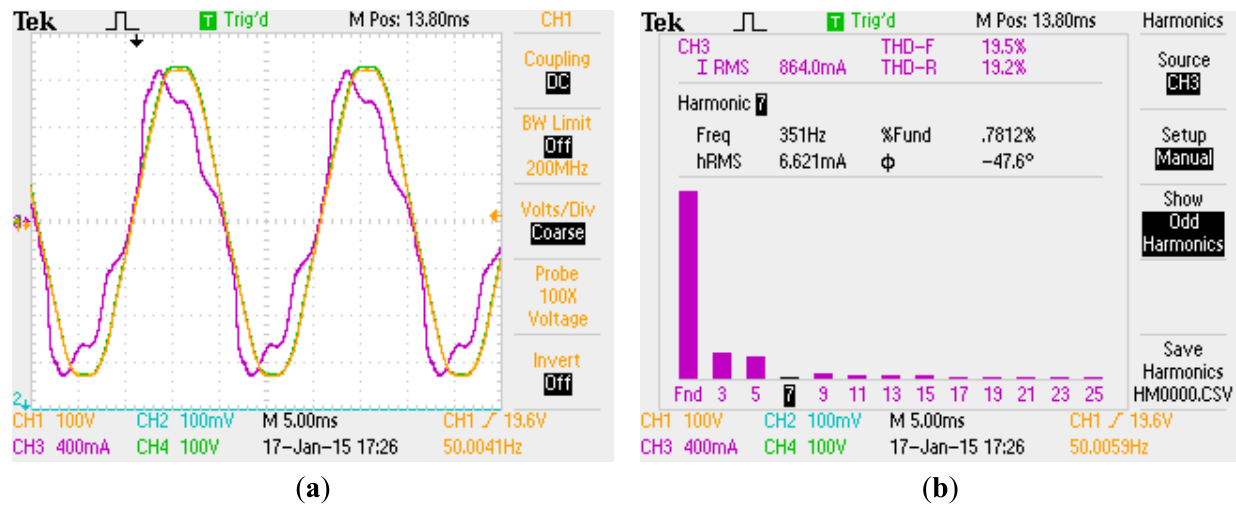
Figure 11. ( a ) Grid’s voltage and current waveforms after compensation of 7th harmonic; ( b ) Grid’s current harmonic spectrum after compensation of 7th harmonic. 7th harmonic is